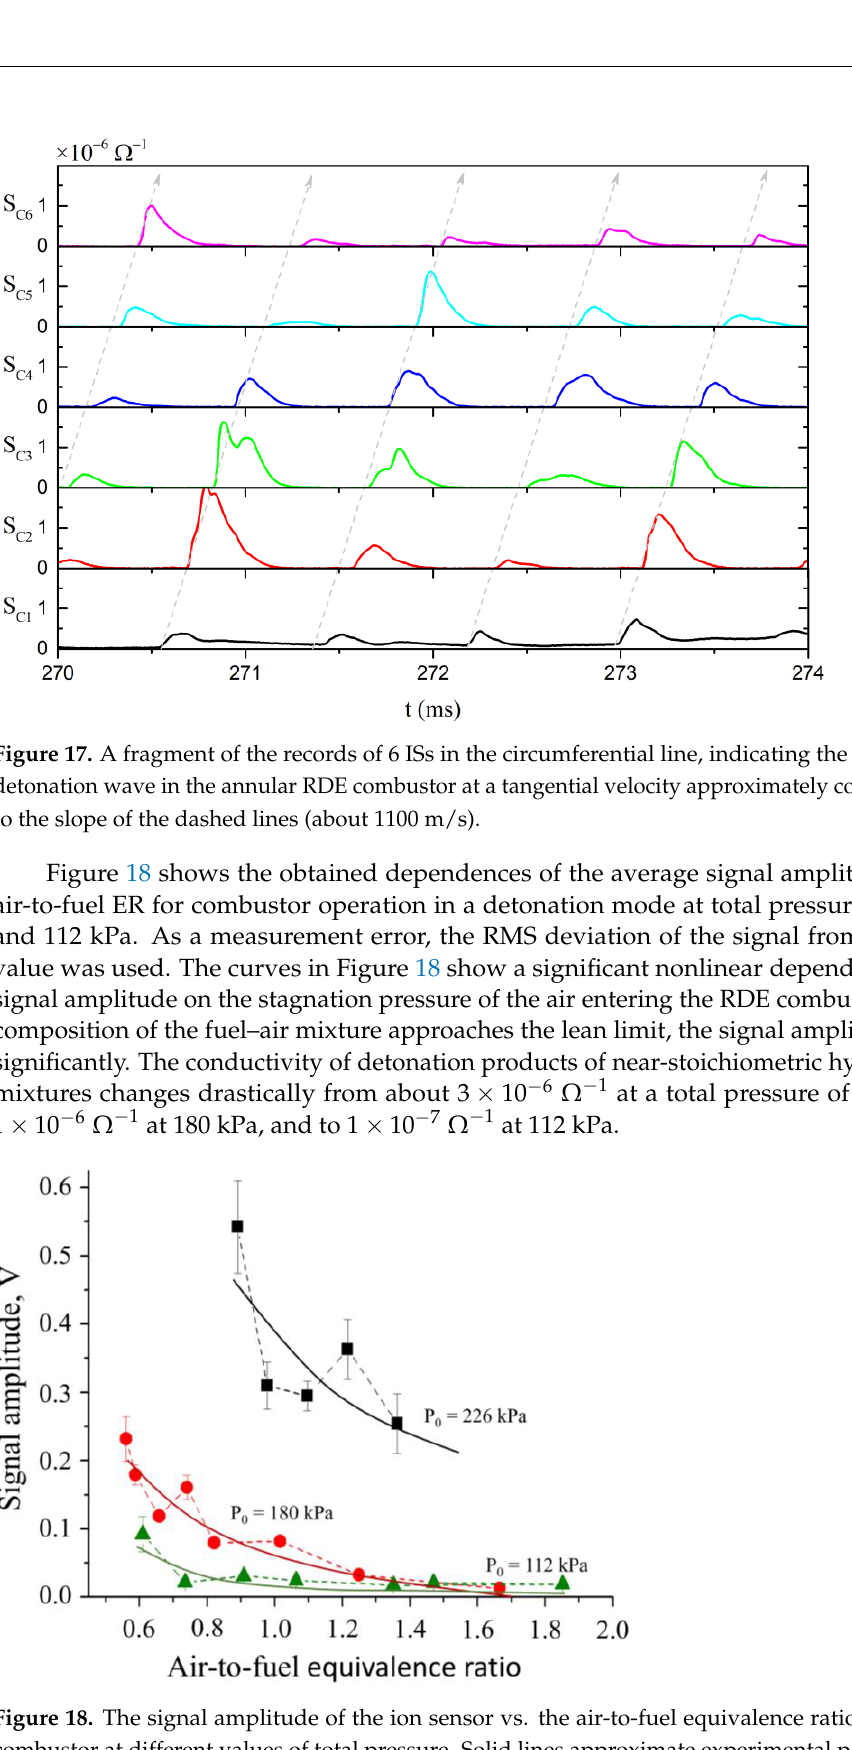
Figure 16. An example of the IS record during RDE operation.